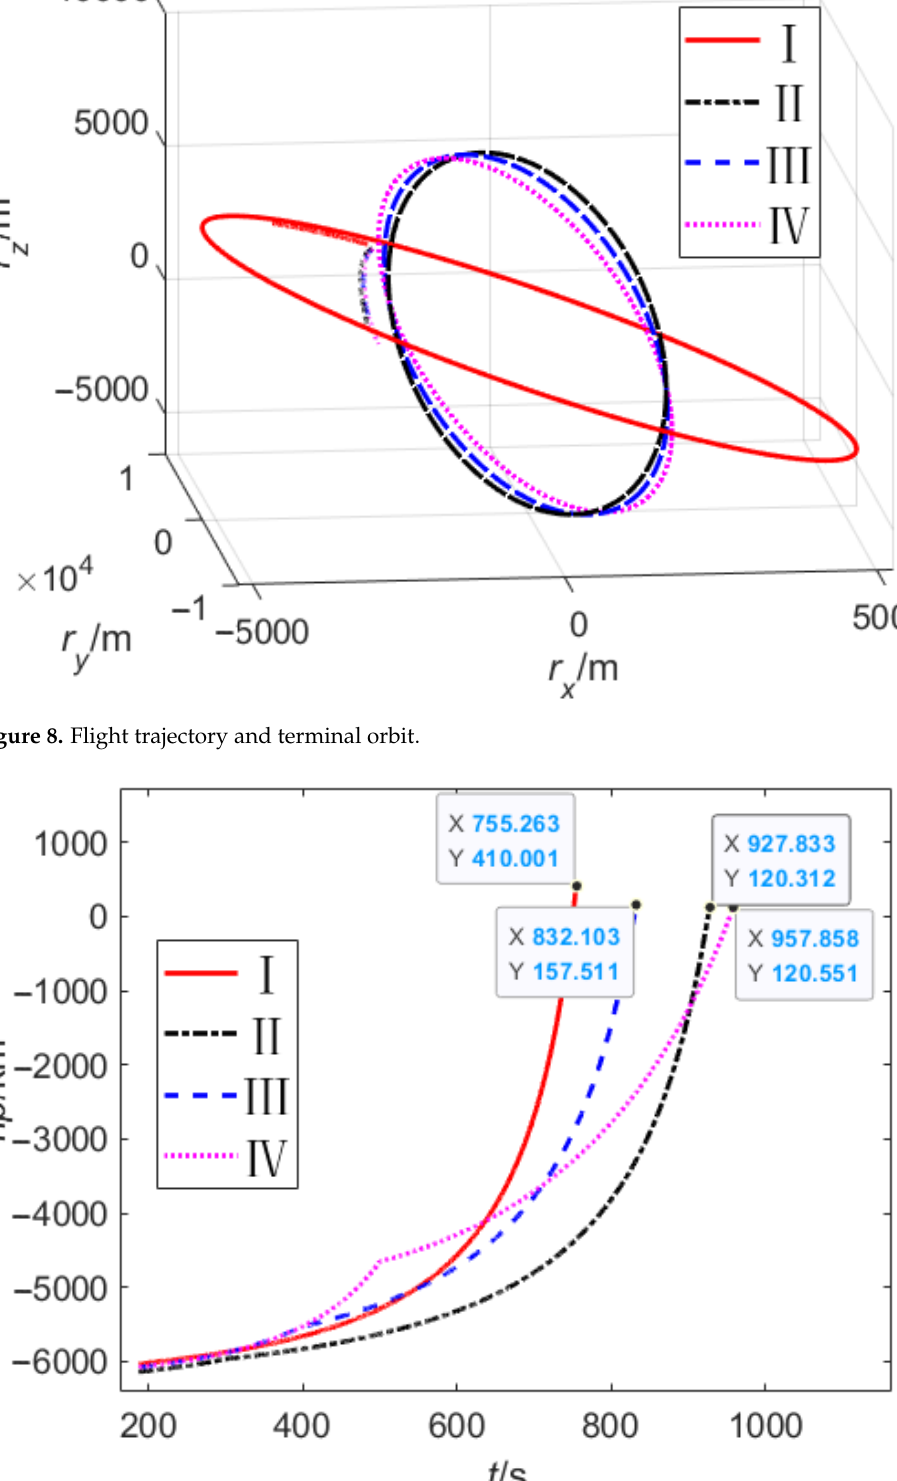
Figure 9. Perigee Figure 9. Perigee altitude.